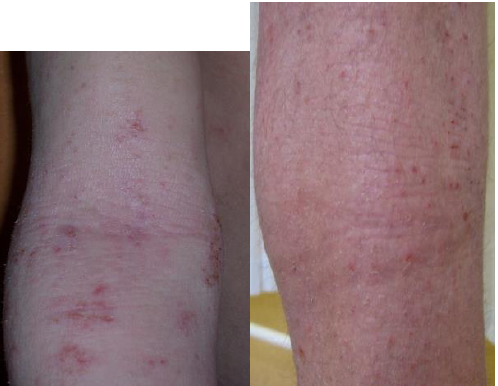
Figure 2. Typical location and morphology of atopic eczema. Photos show typical location of skin lesions in children.